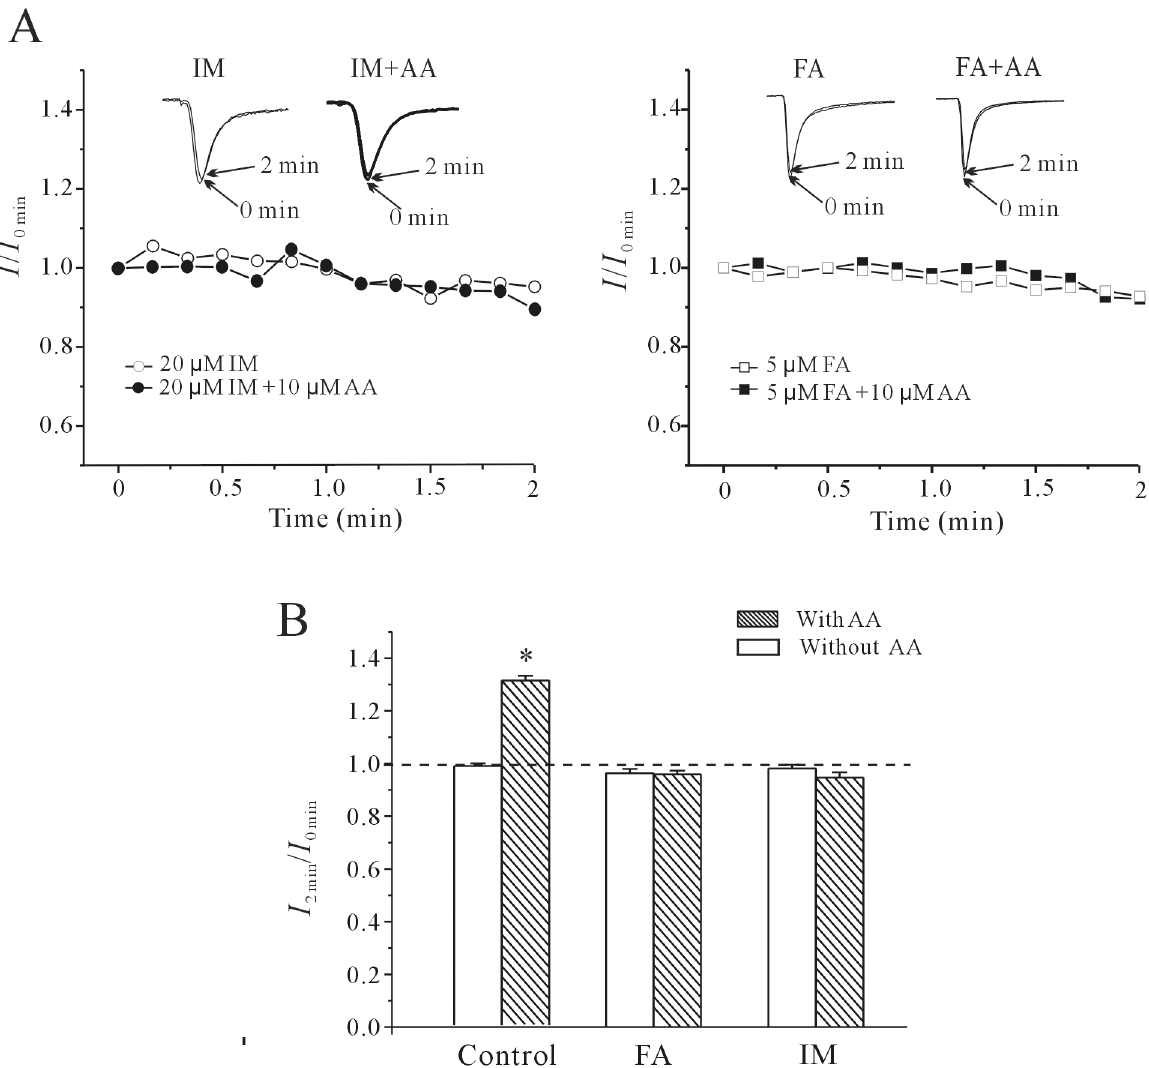
Fig 6. The effect of COX inhibition on rNa V 1.4 current and AA-induced increases in rNa V 1.4 current. (A) Time course of rNa V 1.4 current amplitude obtained after intracellular application of 20 μ M indomethacin (IM) or 5 μ M flufenamic acid (FA), in the presence or absence of AA. The insets show rNa V 1.4 current traces taken from the same cells. (B) Statistical analysis of the effect of indomethacin and flufenamic acid on the amplitude of the rNa V 1.4 current and on the AA-induced increase in rNa V 1.4 current. Results represent the mean ± S.E.M. * , P < 0.05 compared to the corresponding control, using the Student ’ s t